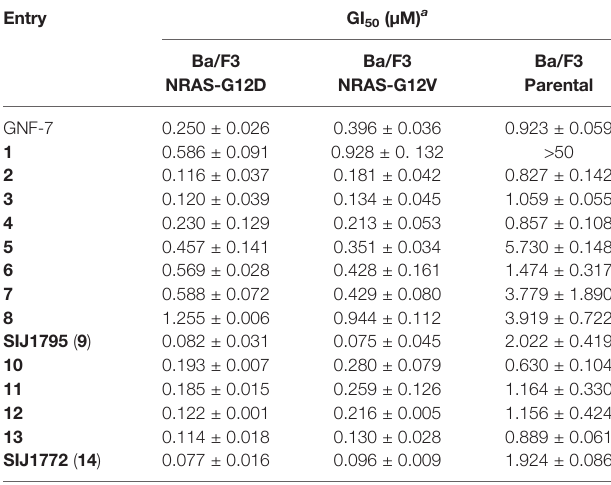
TABLE 1 | Anti-proliferative activities on Ba/F3-NRAS-G12D, Ba/F3-NRAS- G12V, and Ba/F3-parental cells. Entry GI 50 (µM) a